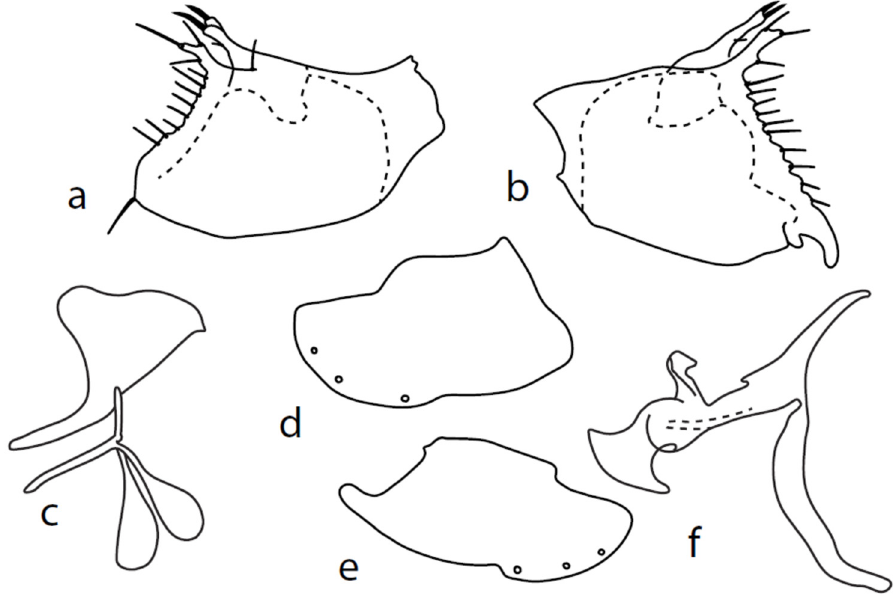
Figure 10. M. rostellatus : ( a ) = right epandrial lamella, ( b ) = left epandrial lamella, ( c ) = postgonite from left, ( d ) = hypandrium from left, ( e ) = hypandrium from right, ( f ) = phallus from left. Microphor strobli Chvála, 1986 Figure 11.